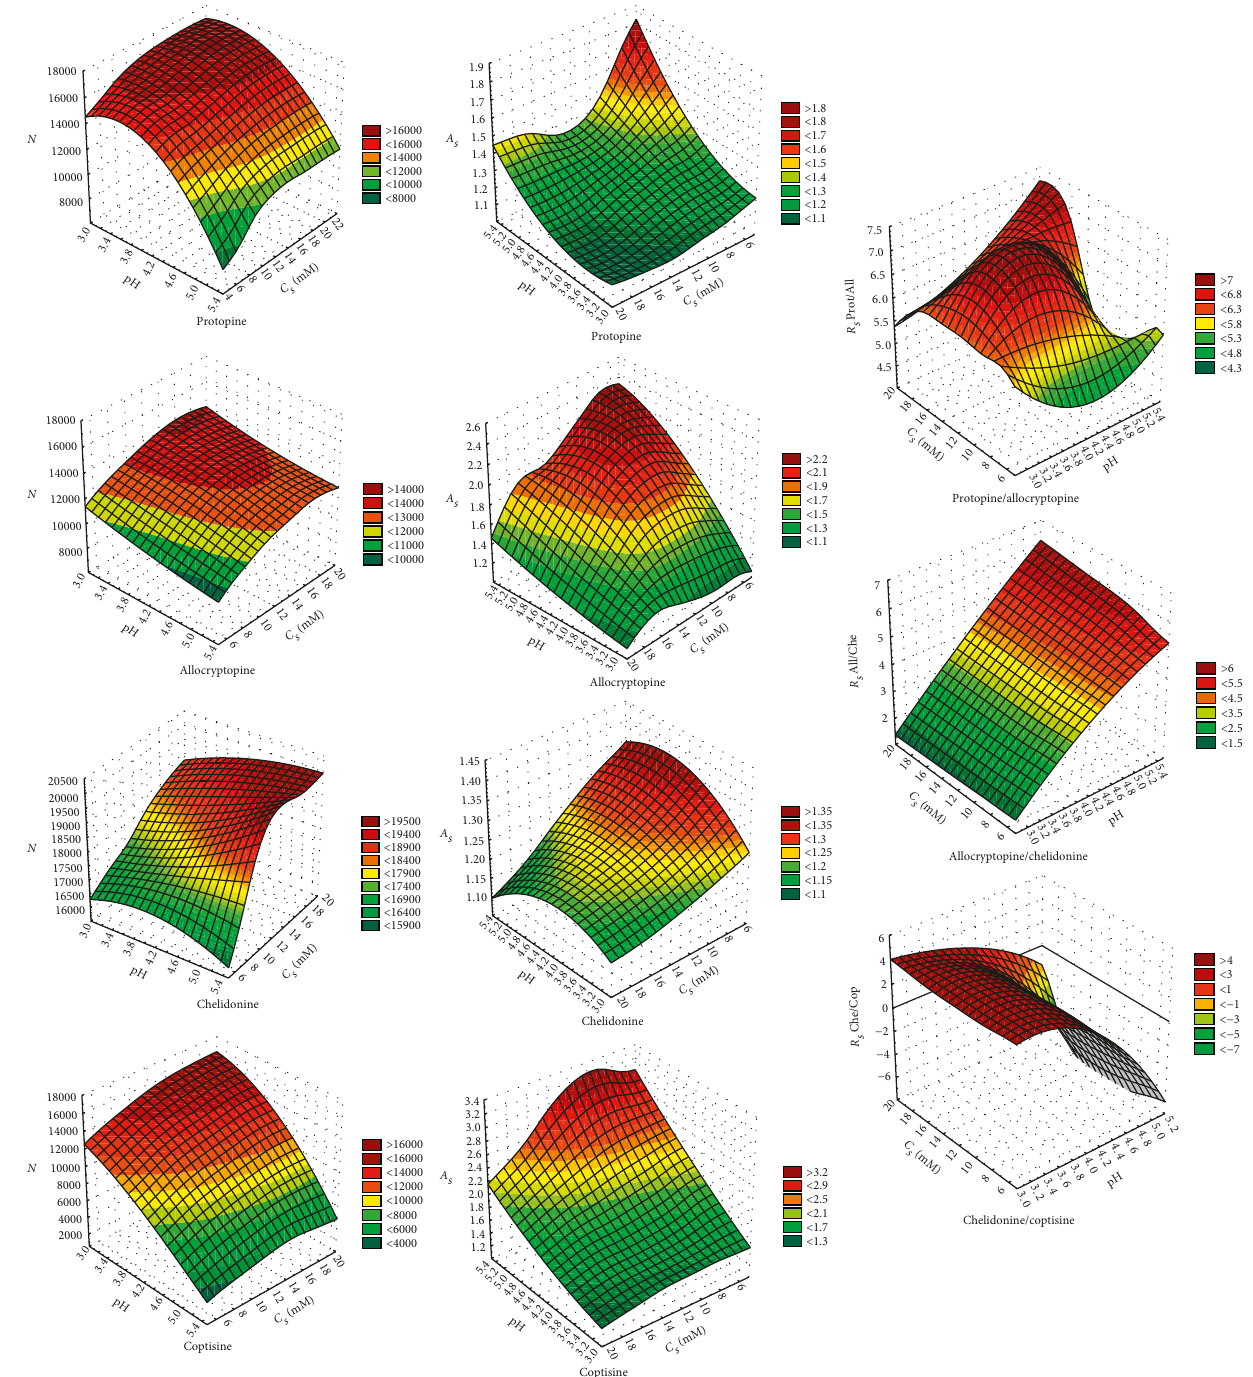
Figure 1: The relationship between theoretical plate numbers ( N ), peak asymmetry ( A